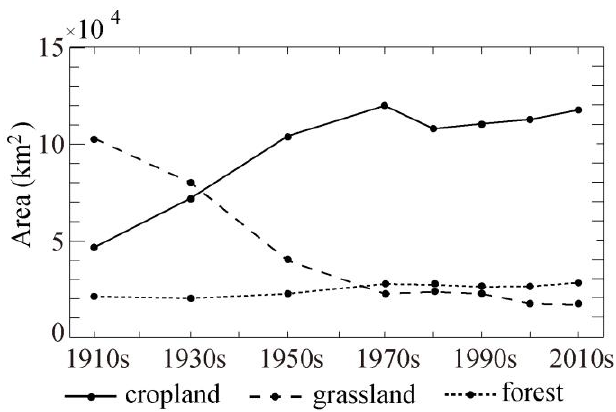
Figure 2. Trajectories of areal coverage of the three primary land use and land cover (LULC) classes (grassland, cropland, forest) in the 1910s–2010s. Table 1. Total area of conversion from the 1900s to 2010s (unit of 10 4 km 2 ). Note there are no developed lands in the 1910s. The three primary classes are highlighted in bold.